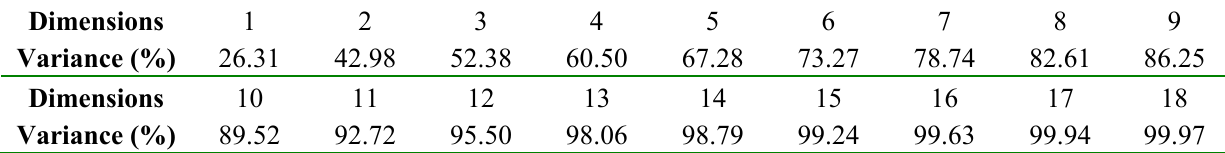
Table 5. Detailed cumulative sum of